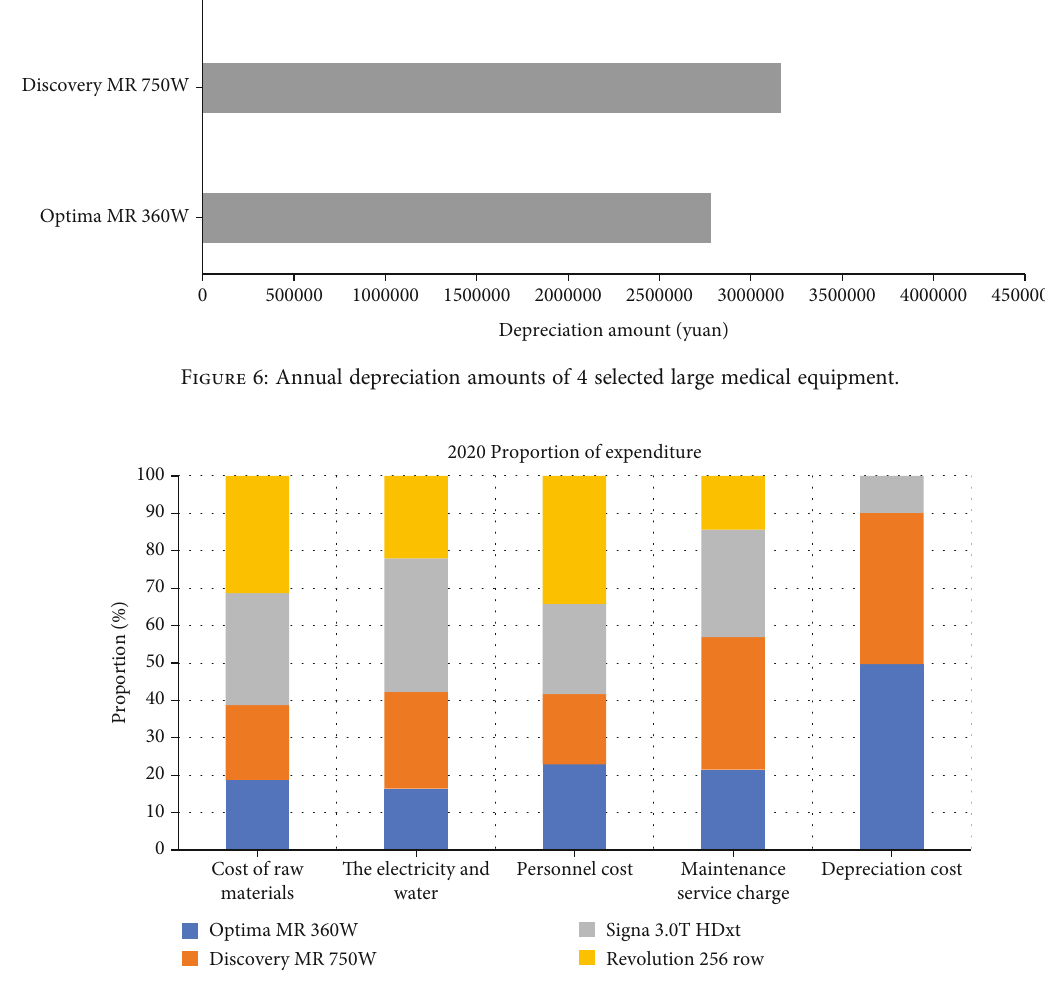
Figure 7: Proportion of expenditure of each equipment in